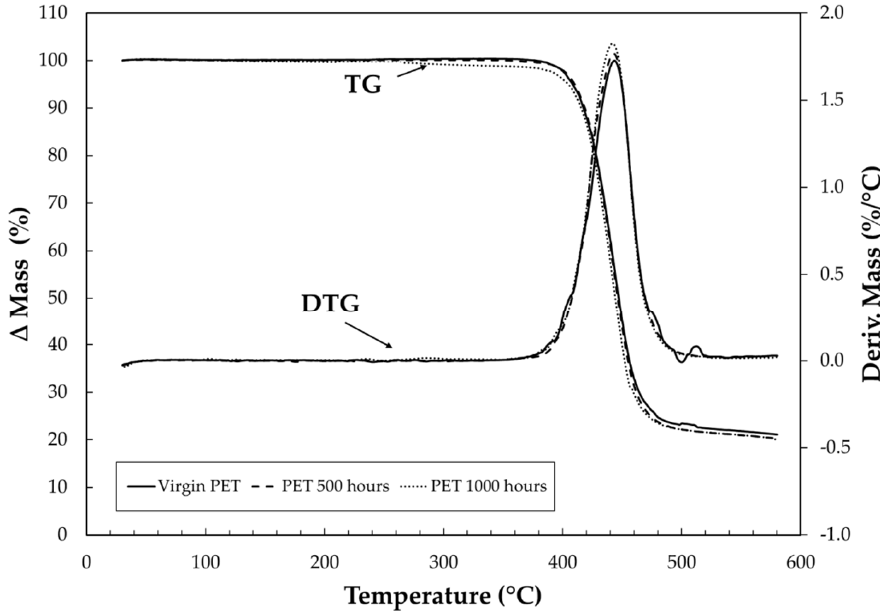
Figure 5. TG/DTG curves of virgin PET, PET 500 h, and PET 1000 h under heating rates of 20 °C·min − 1 under purge gas of carbonic gas with flow of 100 mL min − 1 in α -alumina crucible and sample masses around 3 mg.